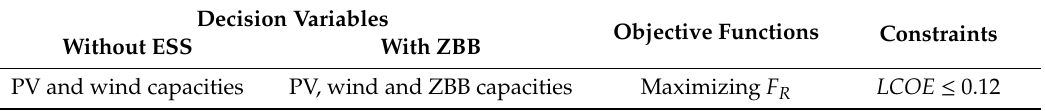
Figure 2. The optimization procedure of the hybrid system components. Table 1. The components of the optimization